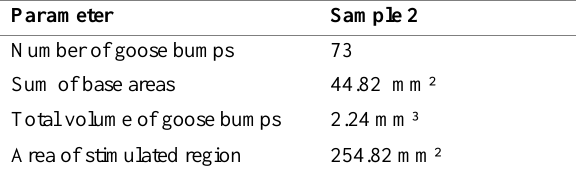
Table 4. Relevant parameter values as result of an sample with very low structured goose bumps (compare Fig.